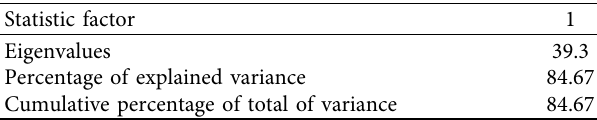
Table 1: The eigenvalues and percentages of variance explained by the extracted factors of API.